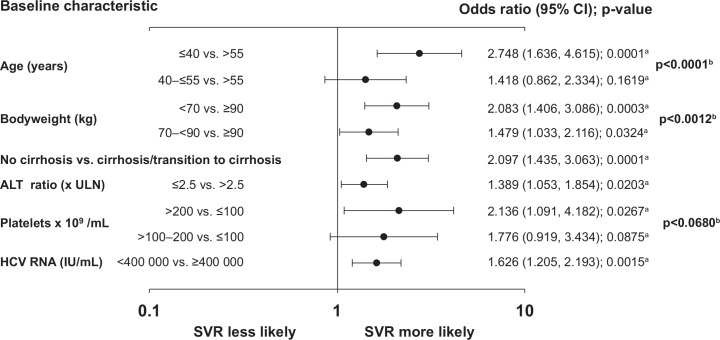
Multivariate logistic regression analysis.ALT = alanine aminotransferase; ALT ratio = ALT divided by ULN for the local laboratory; ULN = upper limit of normal. aWald chi-square test for each regression coefficient; b Wald chi-square test for each variable